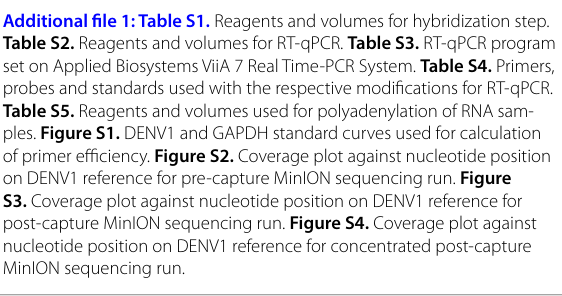
Additional file 1: Table S1. Reagents and volumes for hybridization step. Table S2. Reagents and volumes for RT‑qPCR. Table S3. RT‑qPCR program